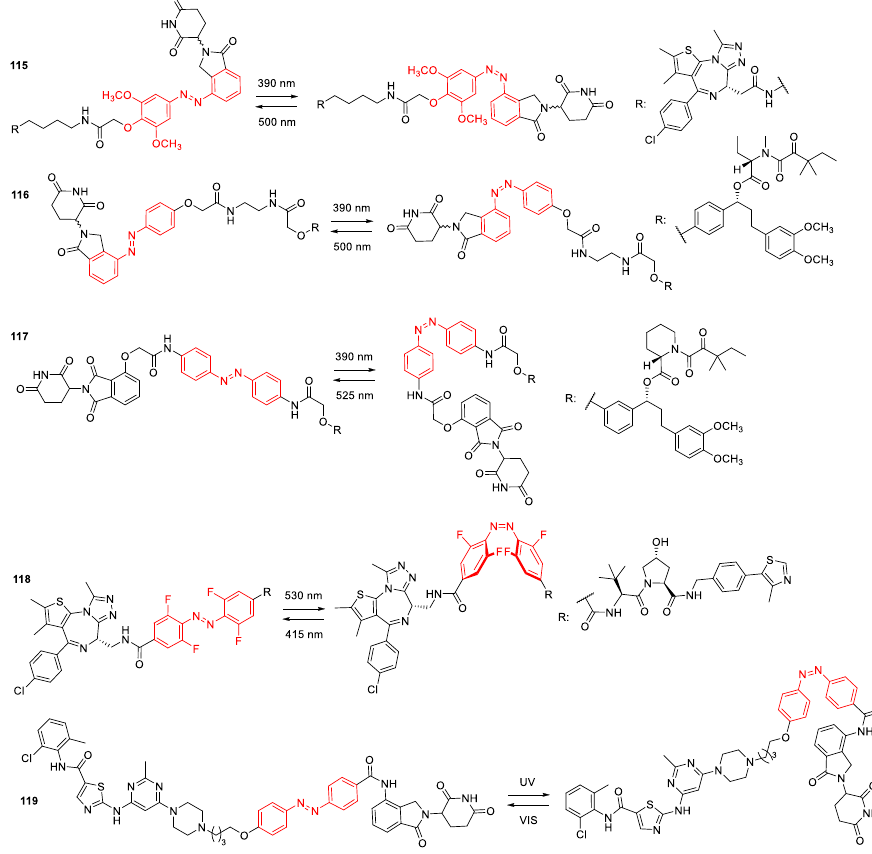
Figure 20. Photoswitchable PROTACs, with the photoswitch unit indicated in red.